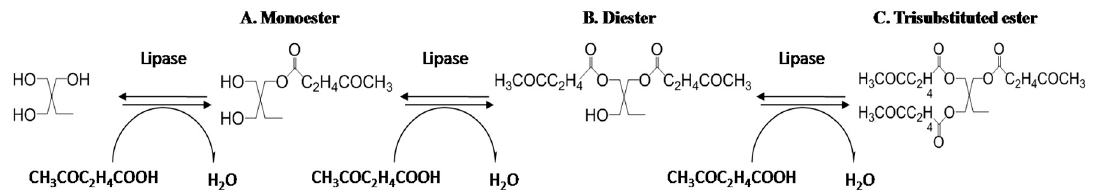
Figure 1. Schematic representation of esteri fi cation reaction between LA and TMP.